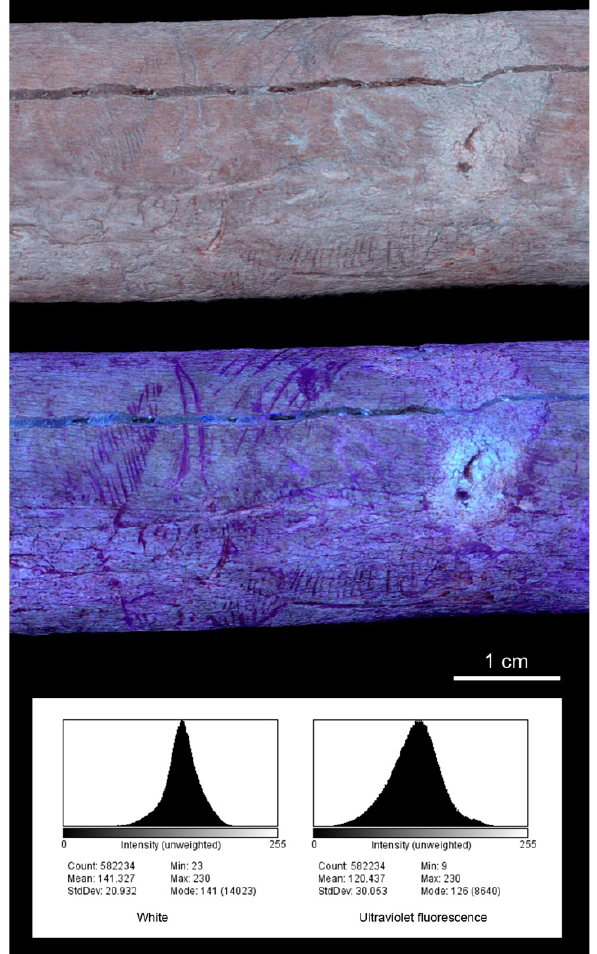
Figure 7: Detail of the 3D model with visible texture on top (https://sketchfab.com/3d- models/1490299c639643ee834fe3a0cd8578ee) and ultraviolet fluorescence texture on bottom (https://sketchfab.com/3d- Figure 6: Turning the engraving upside down to interpret the models/2eef8001f89f4802ab8866806a7e7fb5). The engravings pattern differently. and small cracks are displayed as darker elements in